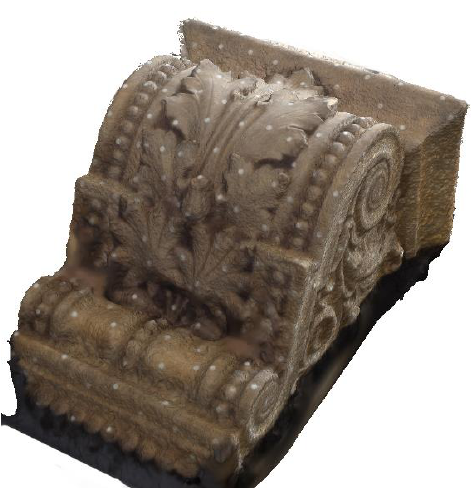
Figure 8 - Mesh of the iPhone point cloud